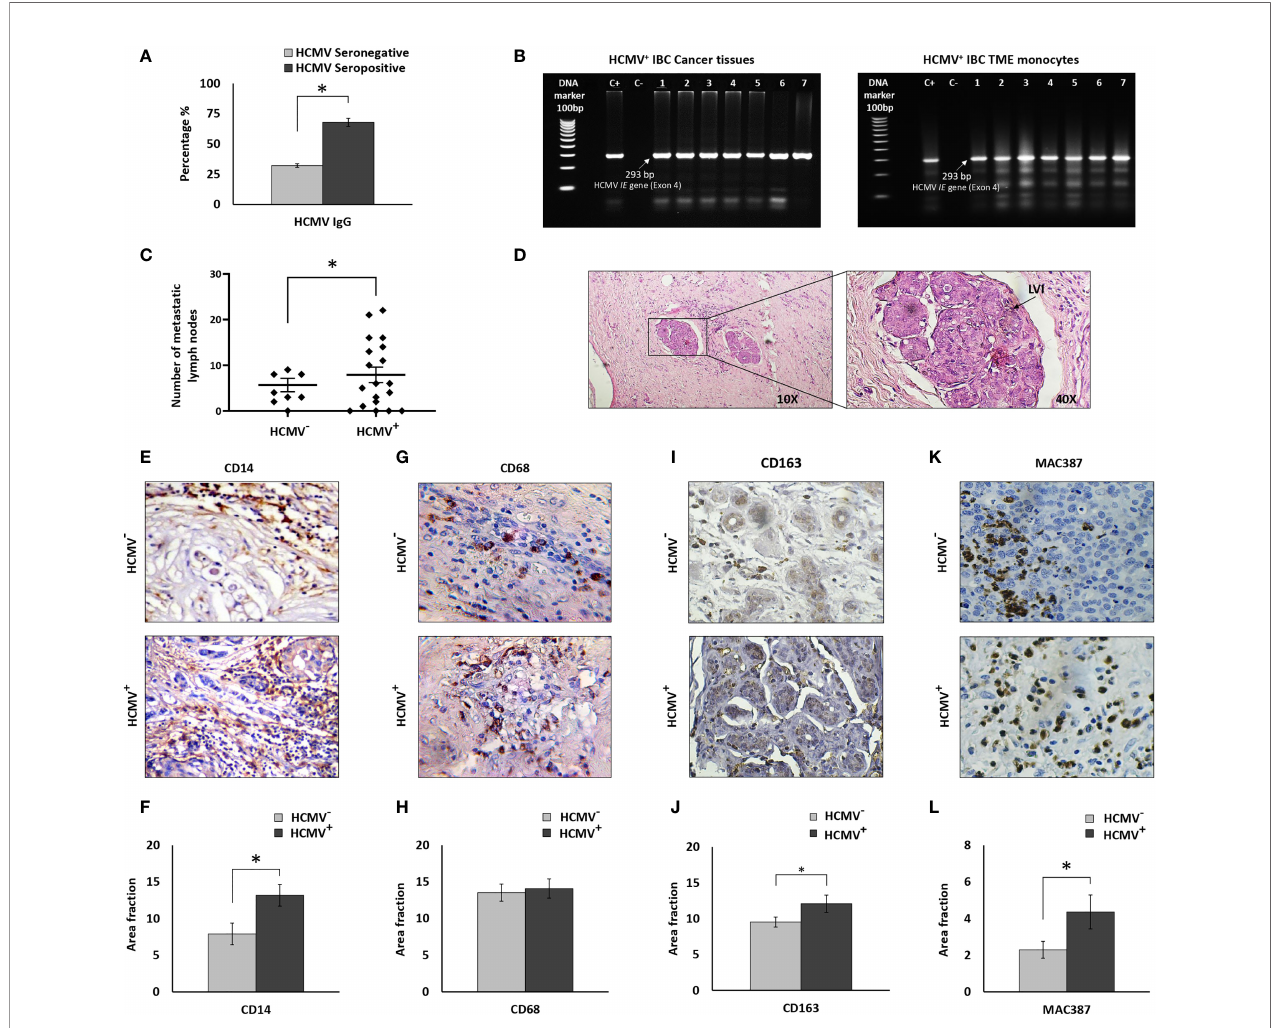
FIGURE 1 | Prevalence of HCMV-DNA among IBC patients and IHC staining of IBC cancer tissues against CD14, CD68, CD163, and MAC387. (A) Bars represent prevalence of HCMV IgG among IBC patients. (B) Representative agarose gel electrophoresis showing amplicons of HCMV Immediate Early ( IE ) gene nested PCR (296 bp) among HCMV + IBC cancer tissues and isolated TME CD14 + monocytes. (C) Scatter plot showing the number of metastatic lymph nodes among HCMV - versus HCMV + IBC patients. (D) Microscopic images of H and E stained paraf fi n embedded tissue section of HCMV + IBC patients showing invasion of cancer cells to lymphatic vessels. (E, F) Microscopic images of CD14 stained paraf fi n-embedded tissue sections in HCMV - versus HCMV + IBC cancer tissues and bars showing a signi fi cantly high prevalence of CD14 + monocytes among HCMV + compared to HCMV - IBC cancer tissues. (G, H) Microscopic images of CD14 stained paraf fi n- embedded tissue sections in HCMV - versus HCMV + IBC cancer tissues. Bars show no signi fi cant difference in the prevalence of CD68 + TAMs among HCMV + compared to HCMV - IBC cancer tissues. (I, J) Microscopic images of CD163 stained paraf fi n-embedded tissue sections in HCMV - versus HCMV + IBC cancer tissues. Bars show a signi fi cantly high prevalence of CD163 + TAMs among HCMV + compared to HCMV - IBC cancer tissues. (K, L) Microscopic images of MAC387 stained paraf fi n-embedded tissue sections in HCMV - versus HCMV + IBC cancer tissues and bars showed a signi fi cantly high prevalence of MAC387 + TAMs among HCMV + compared to HCMV - IBC cancer tissues. Data represented the mean of ± SD. P values were calculated using Student t -test, where * represented ( P <